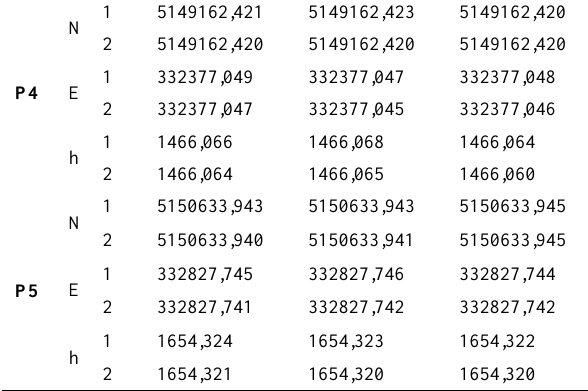
Table 1. GPS Coordinates over time and sessions.